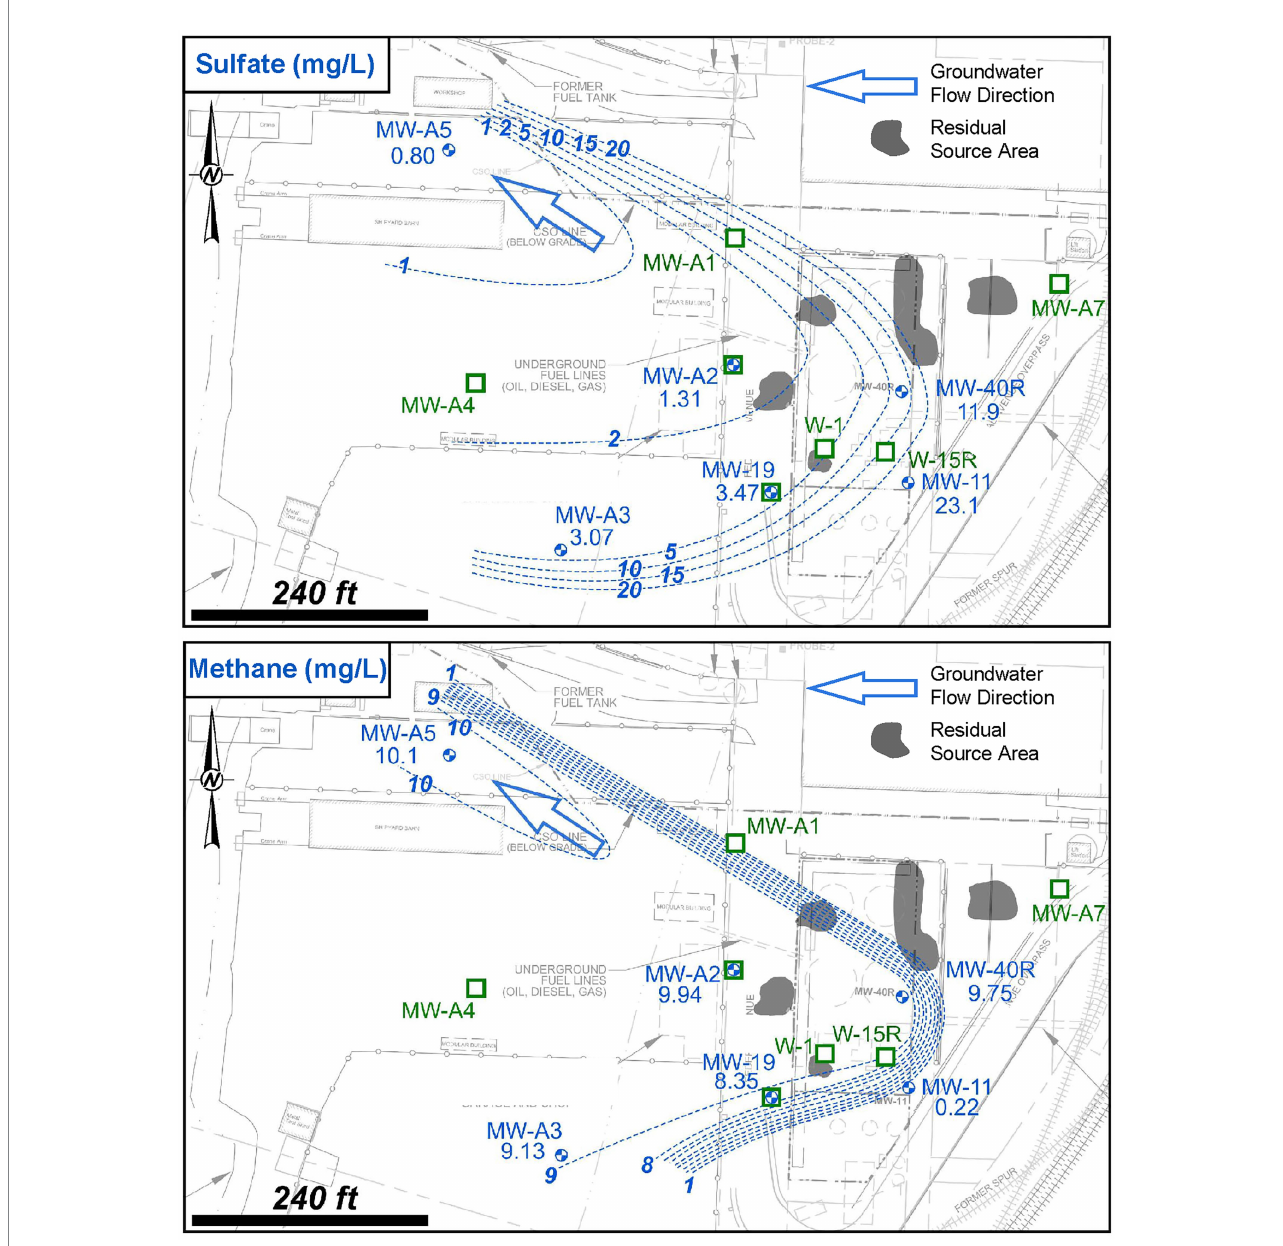
FIGURE 6 Site 2 sulfate (mg/L) and dissolved methane (mg/L) distribution in shallow groundwater as determined during the Assessment